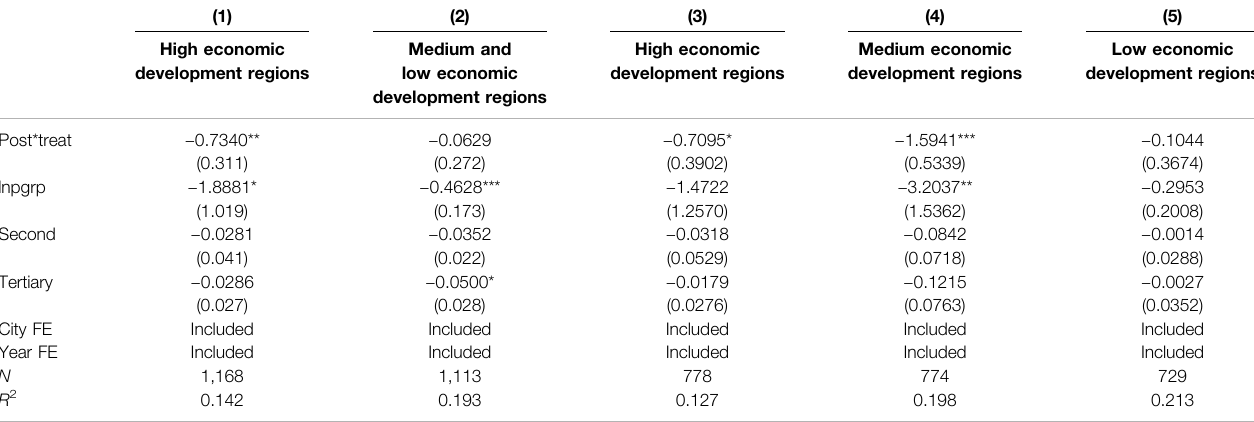
TABLE 6 | The heterogonous impact of “ low-carbon city pilot ” policy on the energy intensity in regions with different economic development.